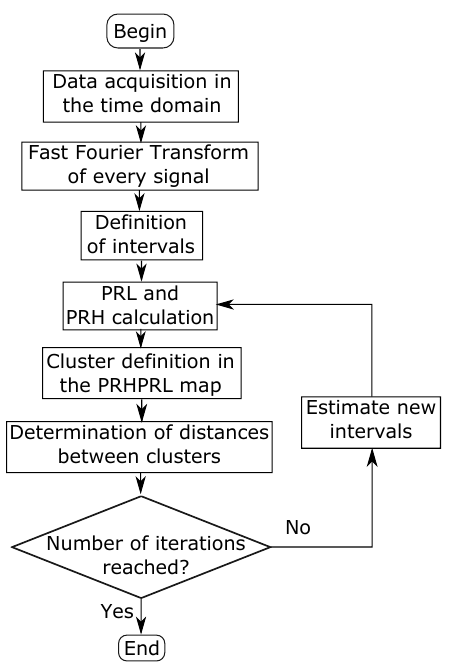
Figure 1. General flow diagram of the algorithm. PRL and PRH are calculated with Equations (1) and (2),